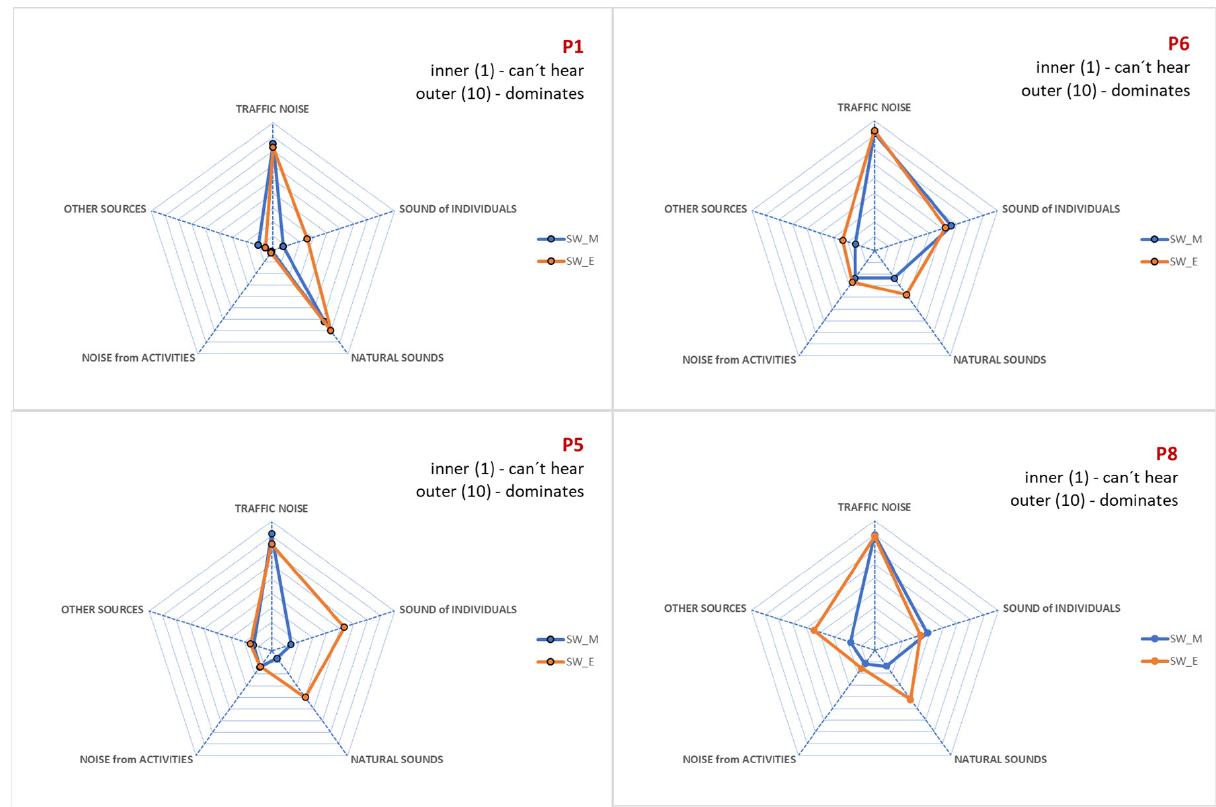
Figure 12: Differences SW_M and SW_E at selected stops within the soundwalk path. P1 and P6 (up) located in (R) urban territory and P5 and P8 at (SEC)